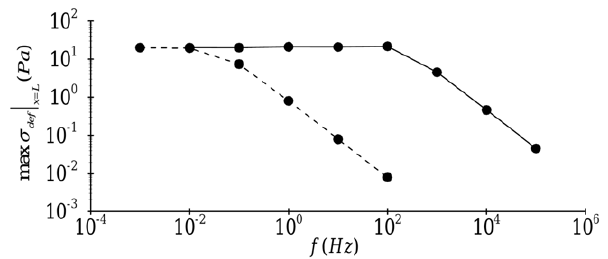
Figure 7. Effect of (A) prestress, (B) elasticity, (C) material viscosity, and (D) cytosolic viscosity on the critical frequency f crit of the deformation-related stress evolution at the nucleus ( x ~ L ):––––, stress in the transverse direction ( s def , v D x ~ L ); - - - -, stress in the longitudinal direction ( s def , l D x ~ L ). Stars denote the reference